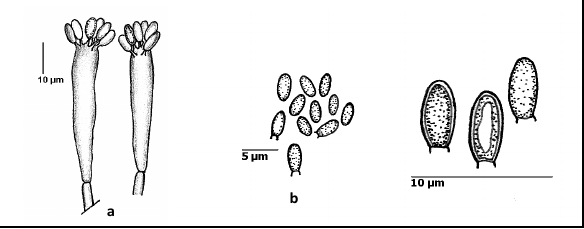
Photo 1. Clathrus archeri : sporocarp